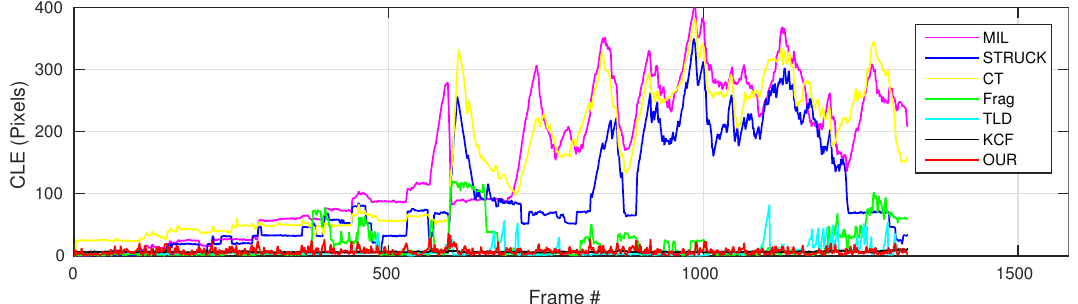
Figure 9. CLE error evolution plot of all trackers with the UGV lp image